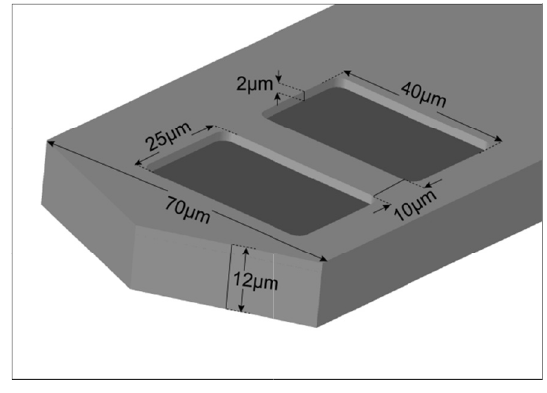
Fig. 1: A schematic of the electrodes with dimensions to scale.